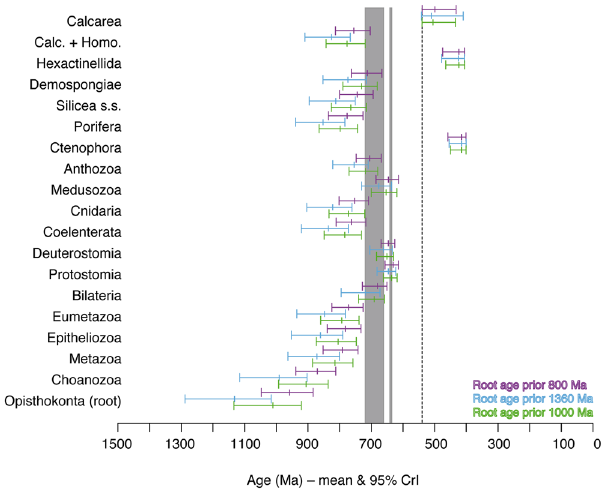
Figure 3. Age estimates for major animal groups obtained under different assumptions about the age of crown-group Opisthokonta. Mean and 95% CrIs of age estimates for select nodes obtained with Calibration set A (see text) under the autocorrelated “ln” relaxed clock model using different root age priors – 1000 ± 100 Ma (lower bars), 1360 ± 100 Ma (middle bars), 800 ± 100 Ma (upper bars). Taxon names refer to crown groups. “Calc. + Homo.” = Calcarea + Homoscleromorpha clade. Dotted line indicates Precambrian/Cambrian boundary. Gray areas indicate Sturtian (left) and Marinoan (right) glaciations 21